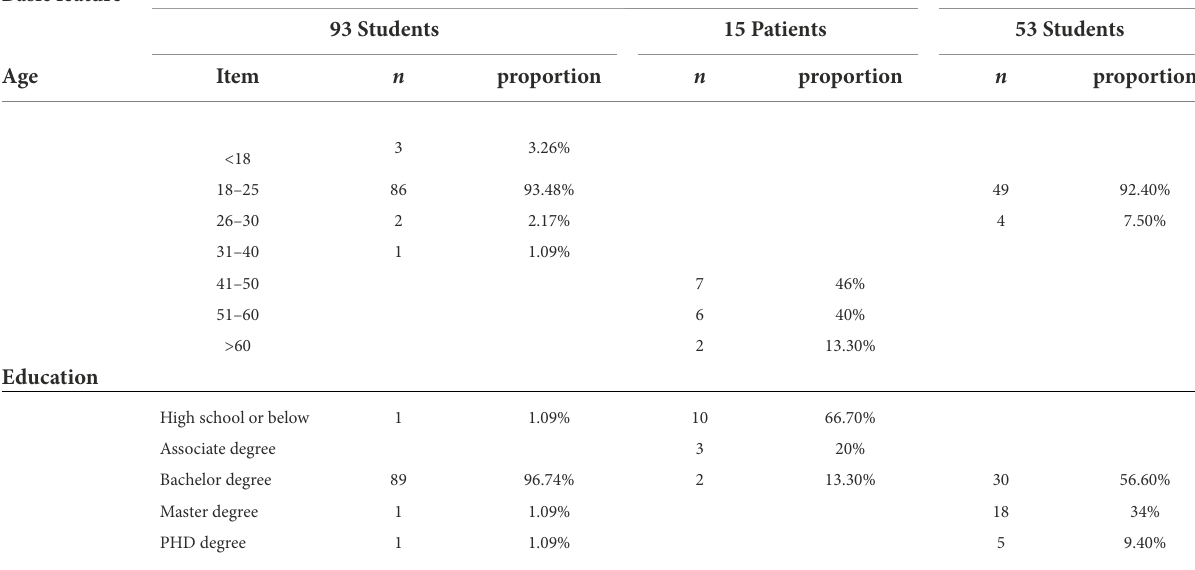
TABLE 3 Basic feature of